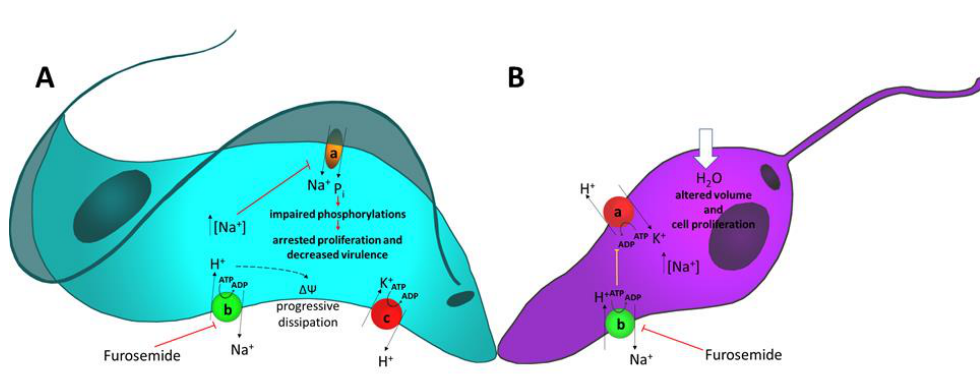
Figure 3. Proposed model for intracellular events in T. cruzi trypomastigotes form ( A ) and L. amazonensis procyclic forms ( B ), triggered by the inhibition of the ENA-type ATPases. Furosemide is used as a model for drugs targeting the pump in protozoan parasites without affecting human host cells. In A, inhibition of Na + -ATPase (red hammer) increases [Na + ] in and decreases the uptake of P i by the Na + :P i symporter [18], thus impairing metabolic phosphorylations, arresting proliferation and decreasing virulence. Additionally, modification of the transmembrane Na + gradient (a higher intracellular Na + ) leads to progressive dissipation of the ΔΨ [28] (dashed arrow). In B, inhibition of Na + -ATPase (red hammer), increases [Na + ] in and thereby the influx of water [67], with subsequent disruption of normal cell volume and impaired proliferation [32]. The decrease in H + influx as the result of inhibition of Na + -ATPase decreases turnover of the plasma (H + +K + )-ATPase [68]. Progressive decrease in K + influx would contribute to arresting growth and cell proliferation.